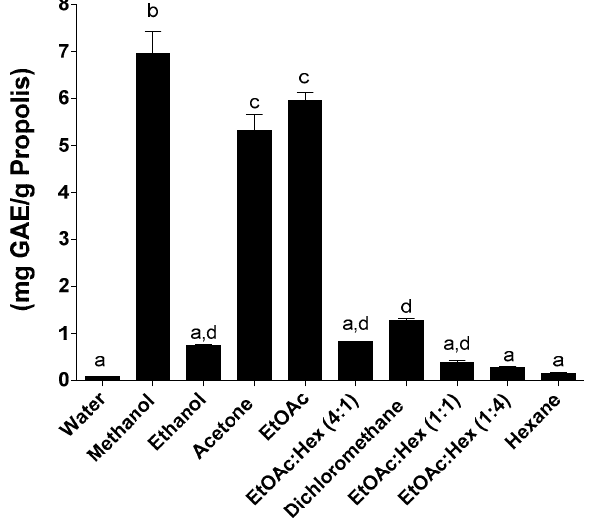
Figure 2. Total phenolic content following MAE. Values are the means ± SEM of at least three independent experiments, each performed in duplicate; values with di ff erent superscripts are significantly di ff erent ( p < 0.05) as determined by one-way ANOVA test with subsequent Tukey’s adjustment; GAE: gallic acid